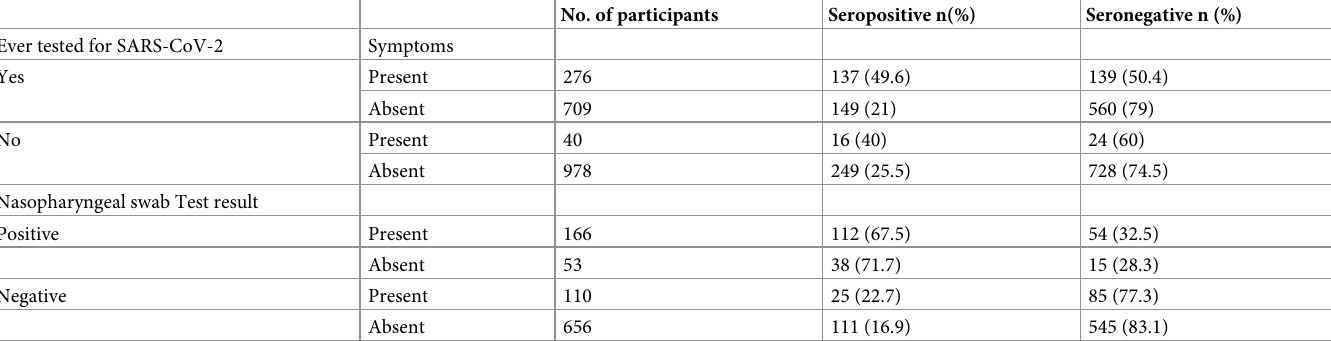
Table 2. Nasopharyngeal swab test characteristics, symptomatology, and seropositivity for SARS-CoV-2 specific IgG.